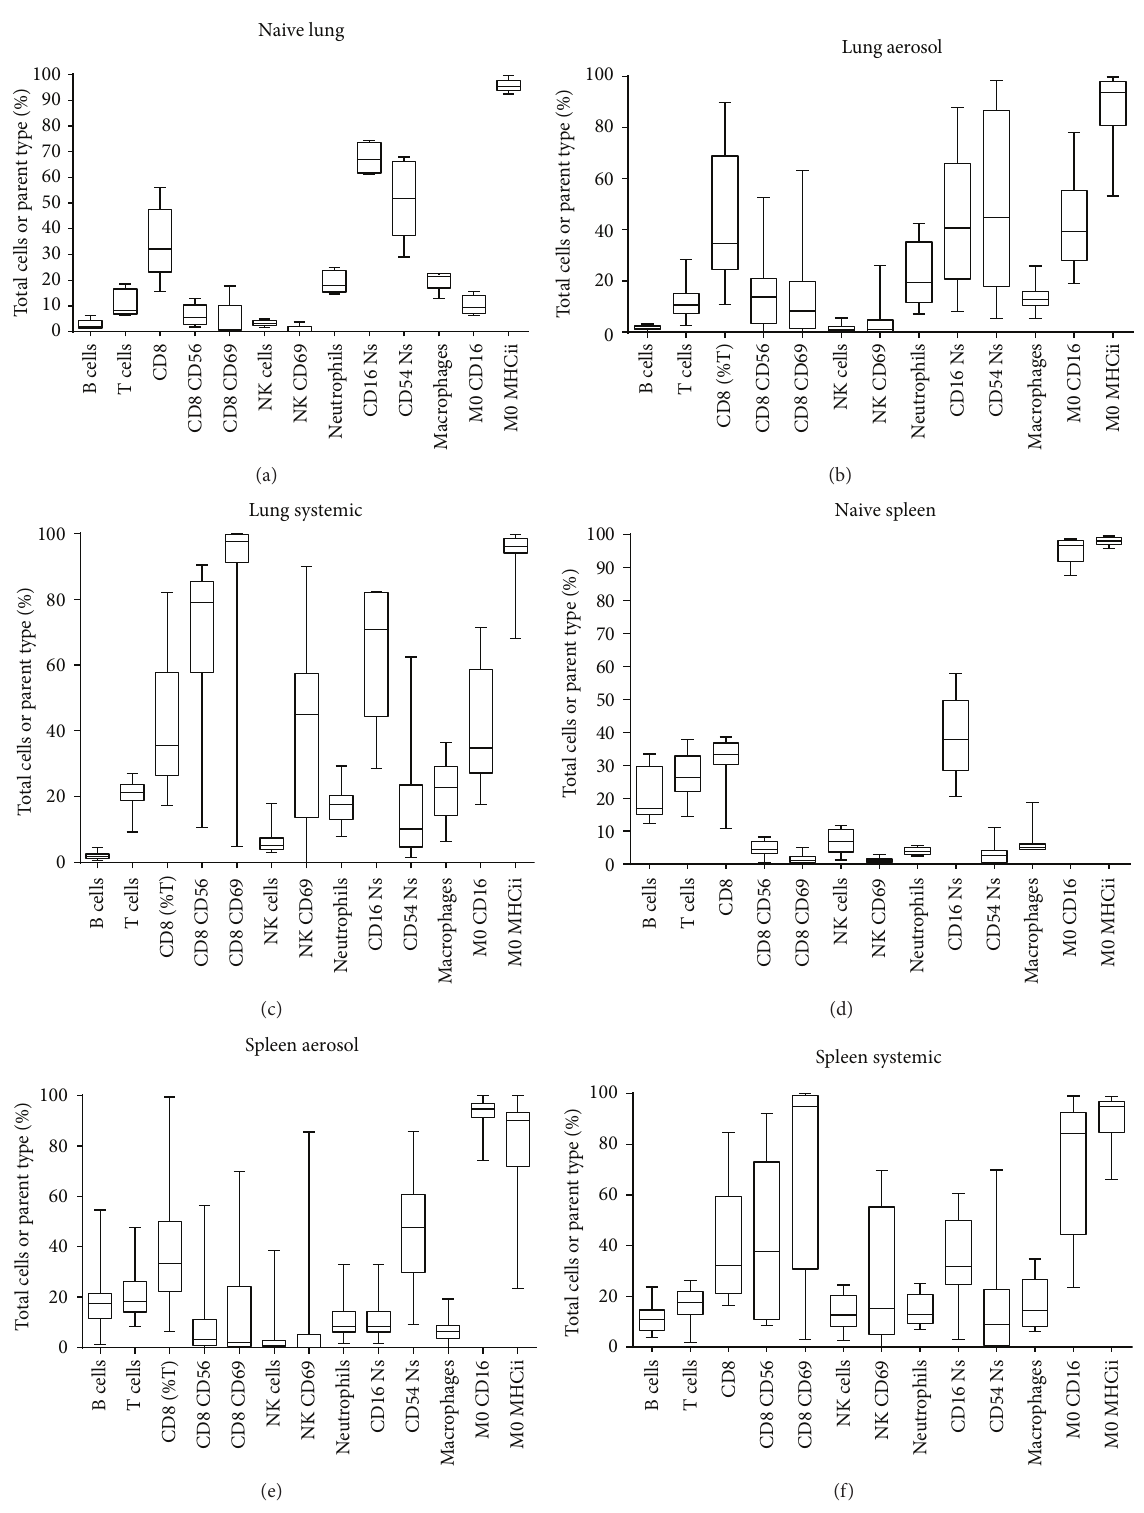
Figure 3: Cell types and activation markers from na¨ıve and after an acute bacterial infection in spleen and lung tissues. Samples were taken at the humane endpoint approx. 4 days after challenge. B, T, NK cells, neutrophils, and macrophages expressed as percentage total whole cells, activation markers as percentages of parent cell type. (a) Na¨ıve lung, (b) lung after aerosol challenge, (c) lung after systemic challenge, (d) na ¨ ıve spleen, (e) spleen after aerosol challenge, and (f) spleen after systemic